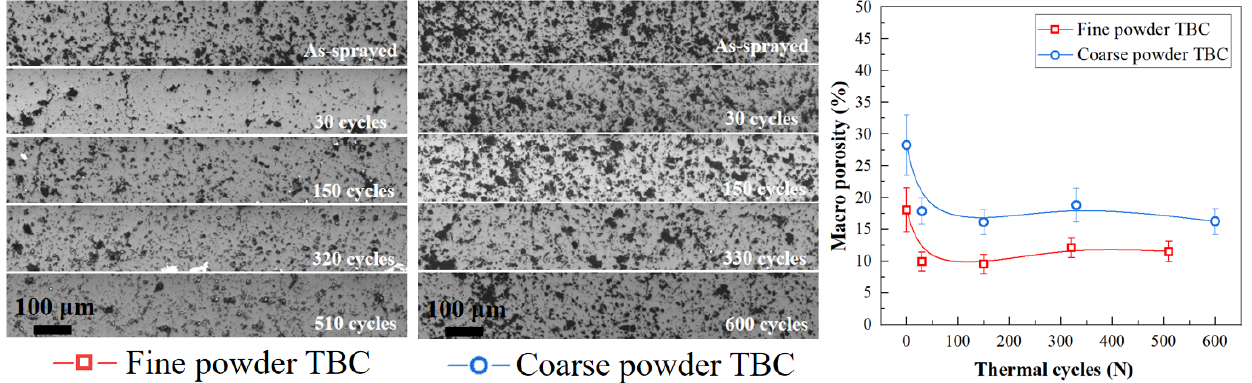
Figure 4. Evolution of porosity of two kinds of coatings during thermal cycling test.